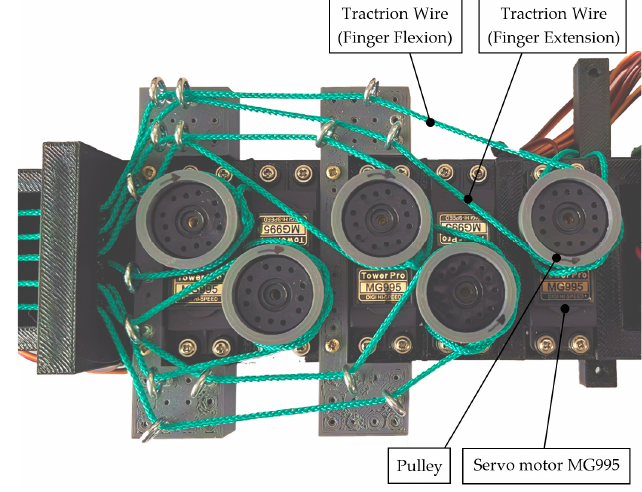
Figure 4. Prosthesis control servo motors.